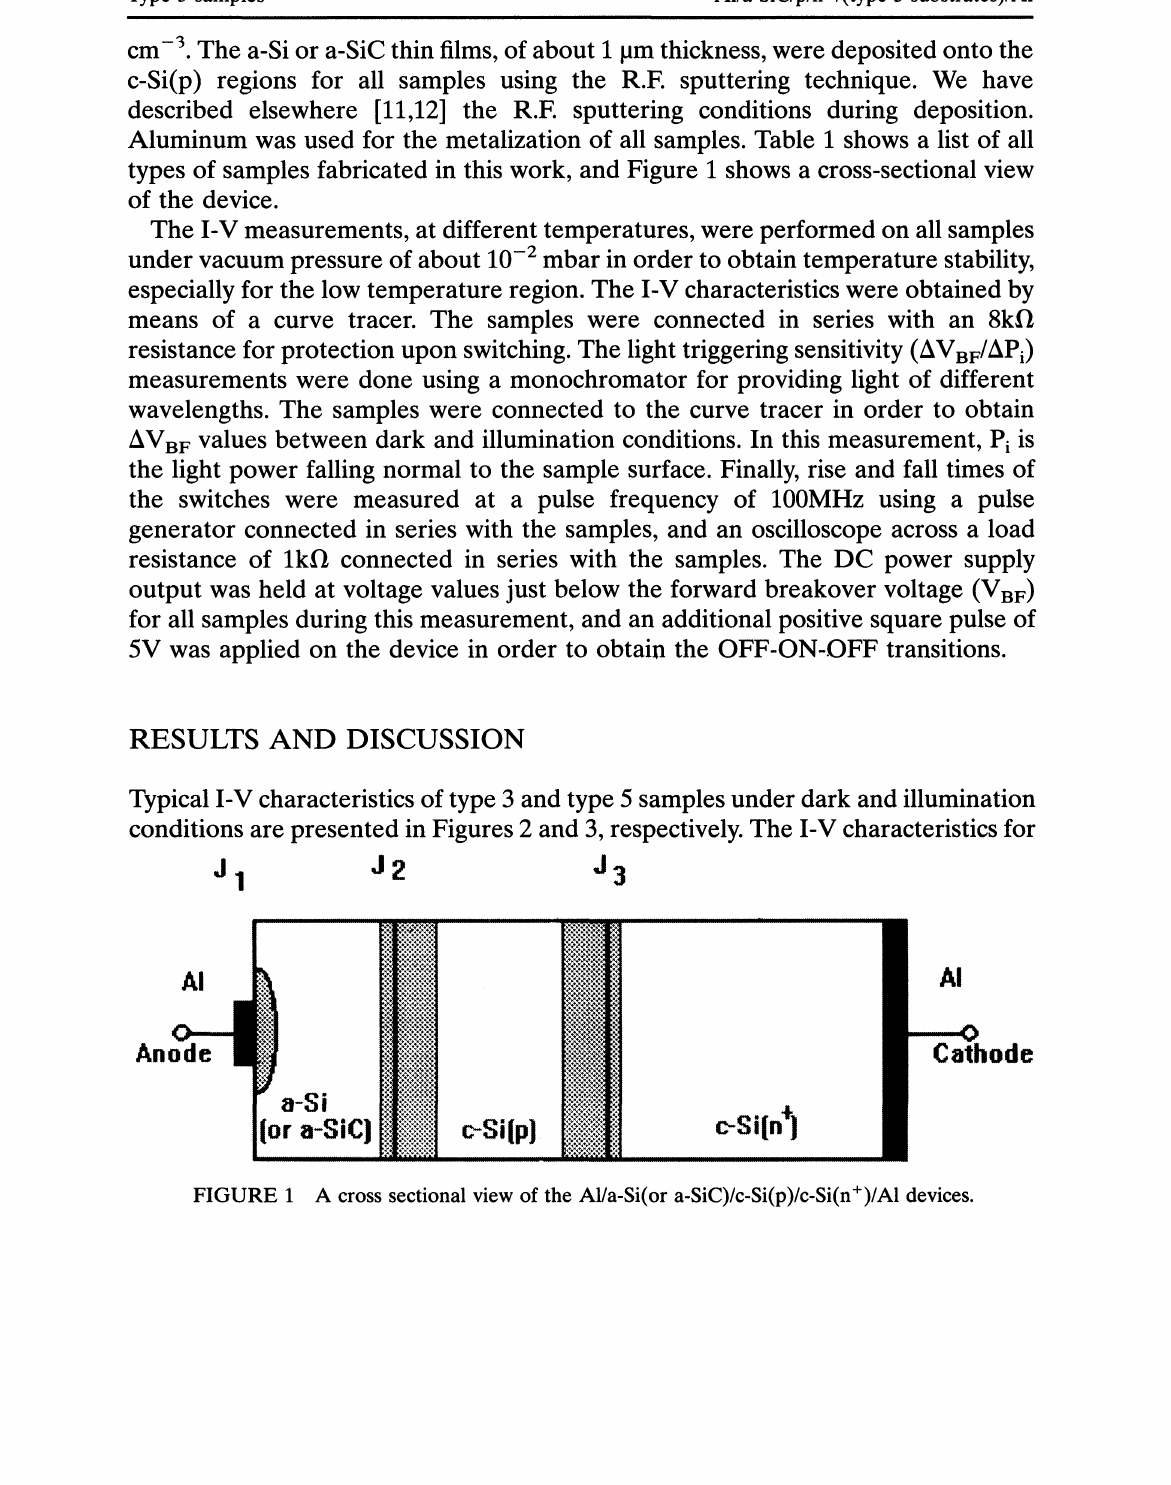
TABLE 1 A list of all types of samples fabricated in this